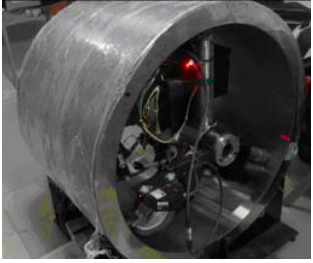
Figure 4. Experiment on the measurement system in the laboratory.